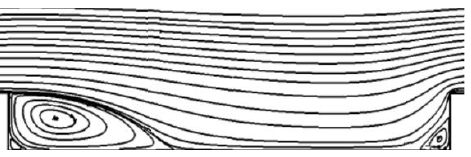
Figure 6. The streamlines for a gas-droplet flow between two ribs. Re = U m 1 H / ν = 1.6 × 10 4 , h / H = 0.1, p / h = 10, H = 40 mm, h = 4 mm, p = 40 mm, U m 1 = 6 m/s, T 1 = 293 K, T W = 373 K, d 1 = 15 μm, M L 1 = 0.05.